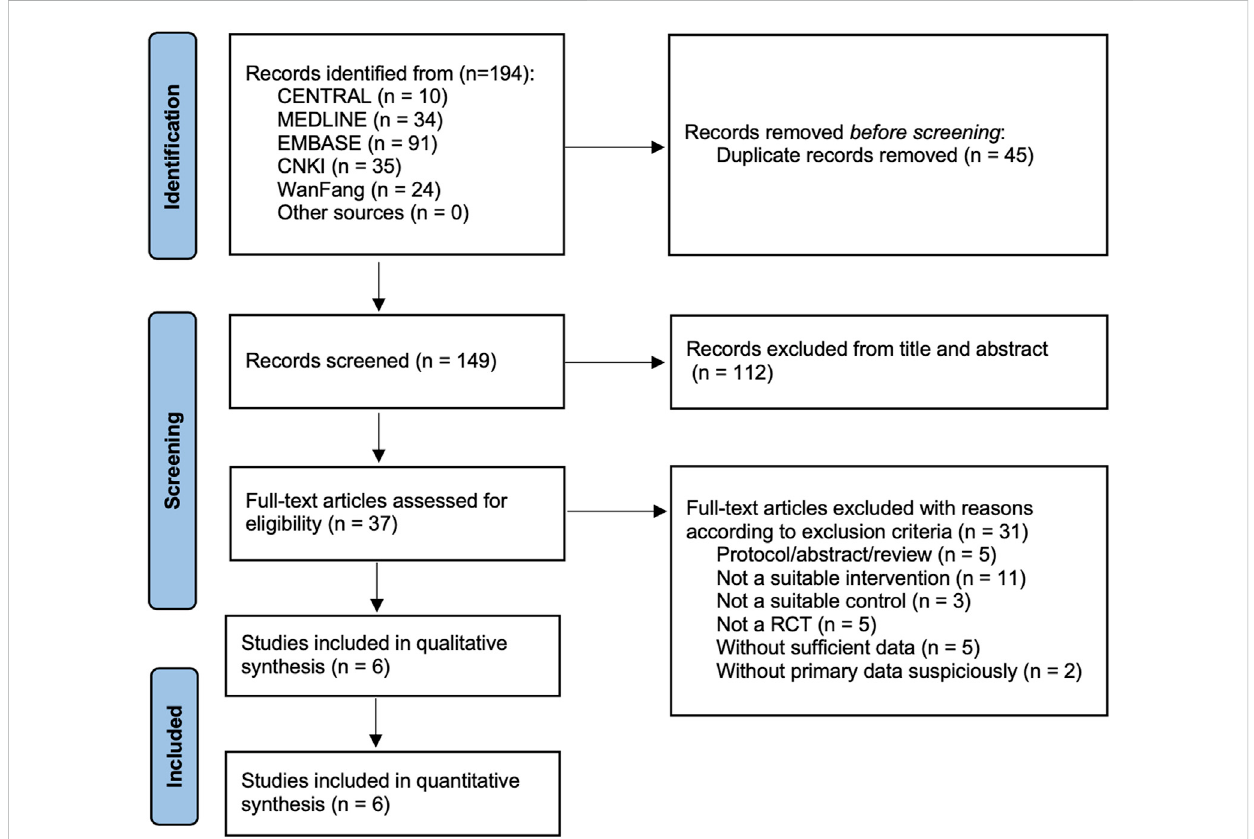
FIGURE 1 PRISMA fl owchart represents the fl ow of information through the different phases of the systematic review and meta-analysis.